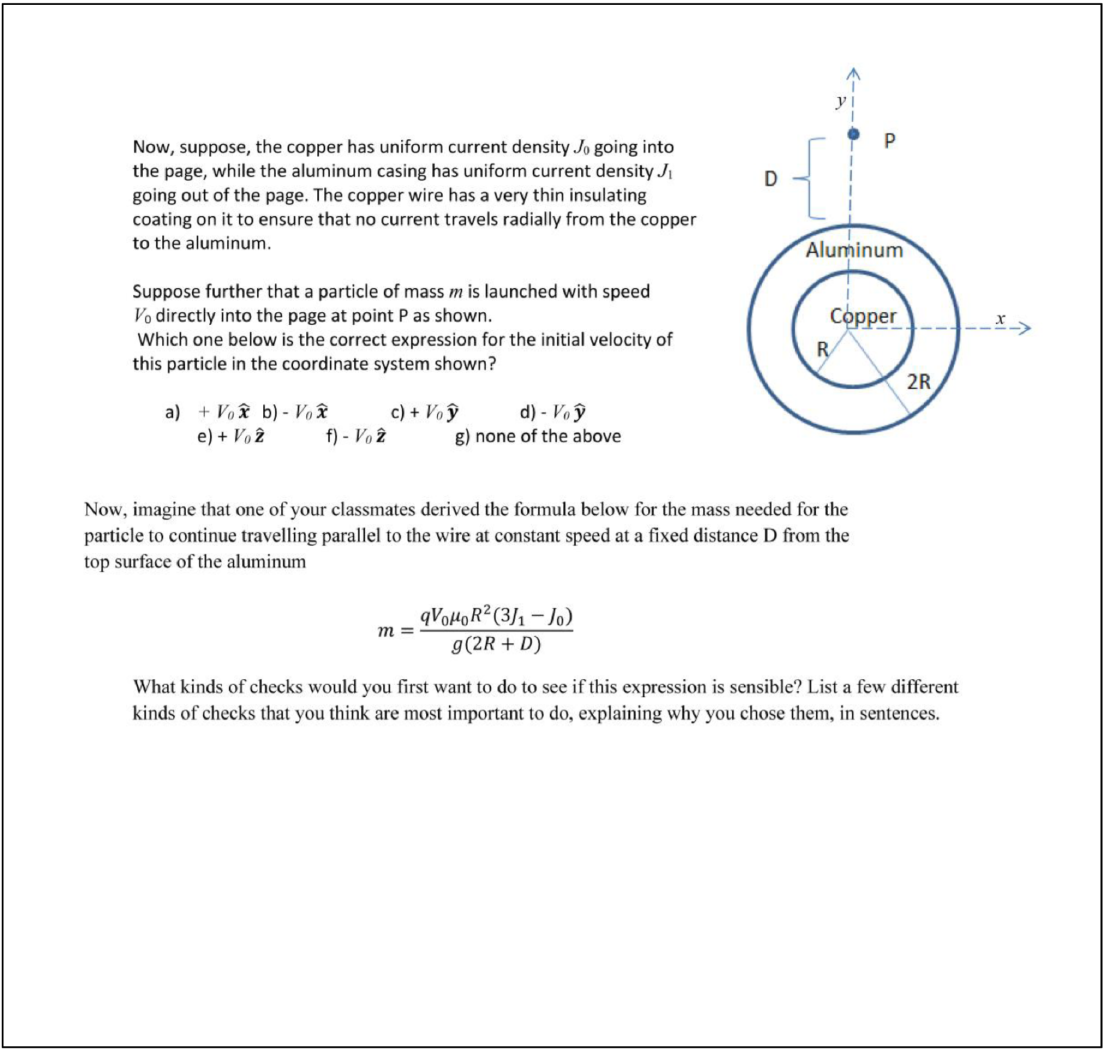
FIG. 13. Aluminum and copper wire problem referenced in Fig. 4, layer 2 of